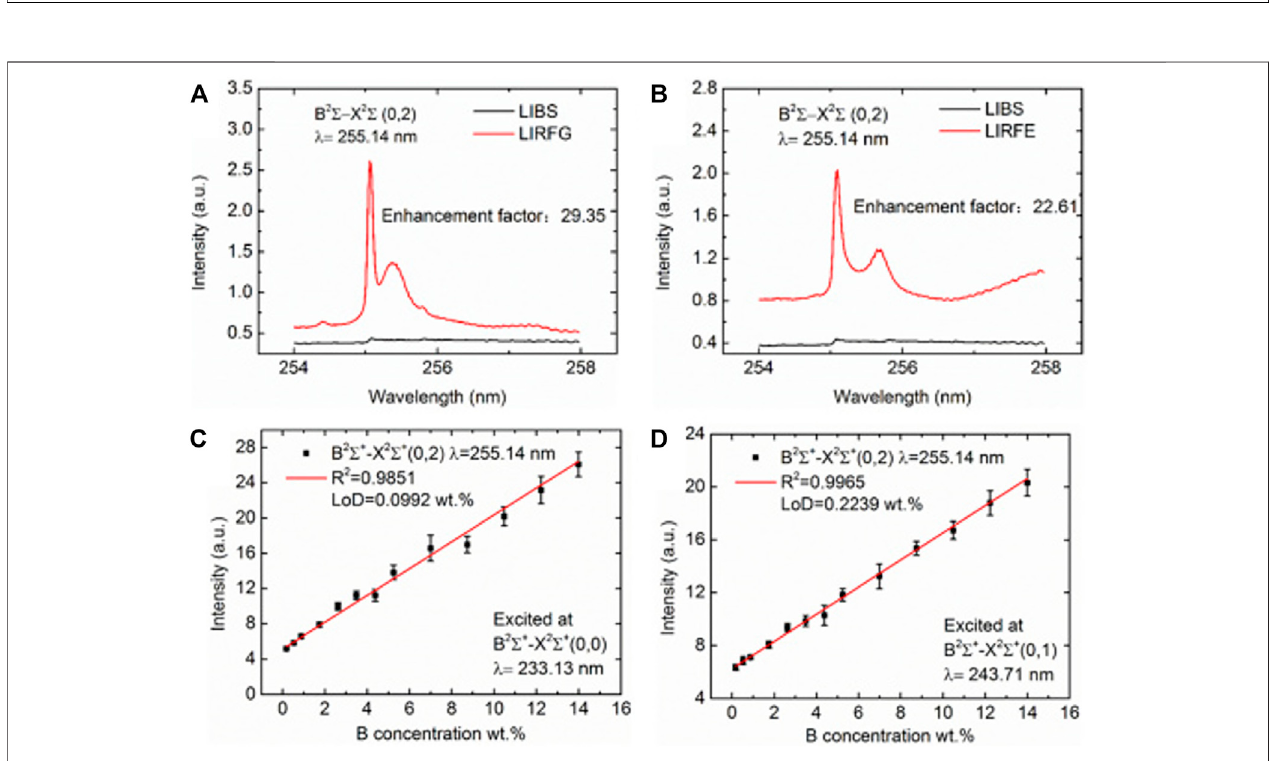
FIGURE 4 | Spectral comparisons of (A) LIBS and LIRFG and (B) LIBS and LIRFE. Calibration curves of BO in (C) LIRFG and (D) LIRFE. [50].